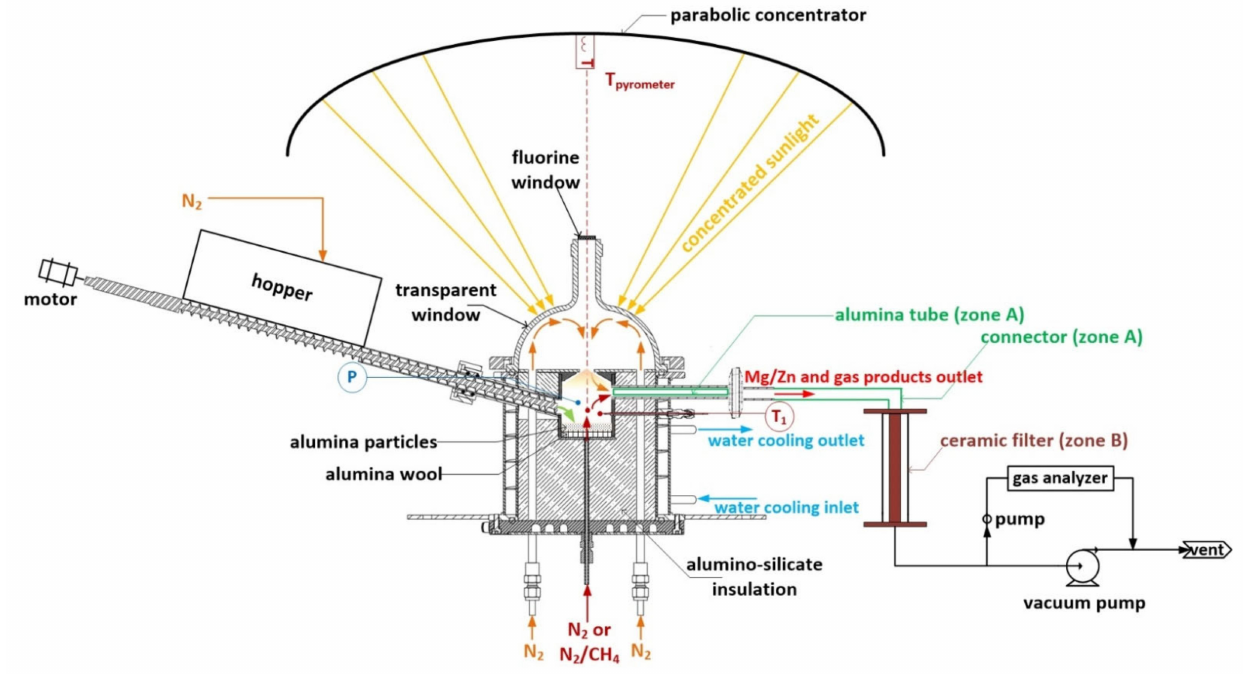
Figure 1. Schematic illustration of the 1.5 kWth metallurgical solar reactor driven by concentrated sunlight for the CTR and MTR of ZnO and MgO. Reproduced with permission from Chuayboon and Abanades [29]; Journal of Cleaner Production ; published by Elsevier,